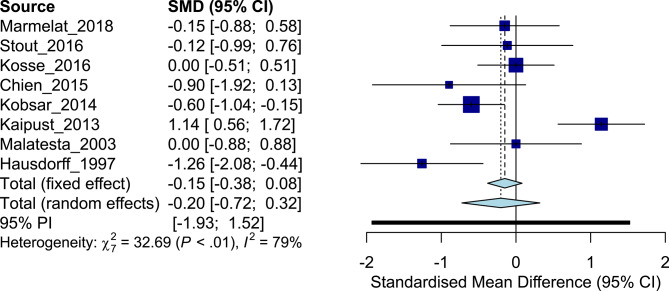
Forest plot: young adults vs. older adults.